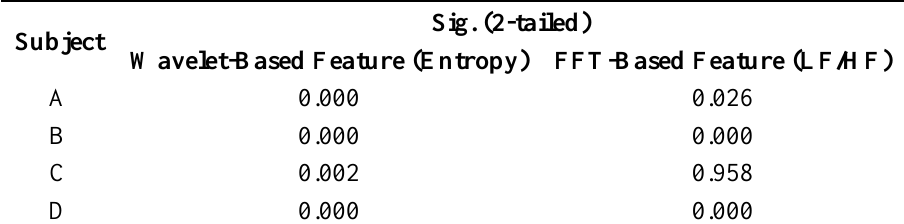
Table 7. Statistical significance tests